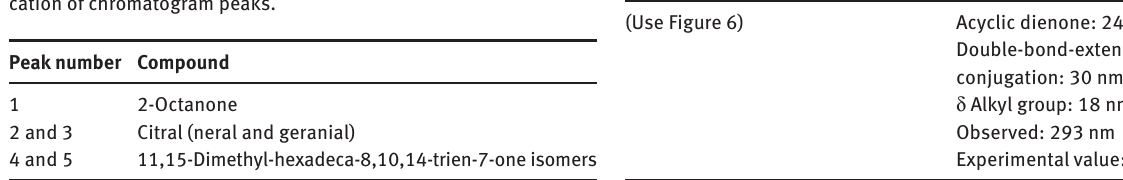
Table 3: Gas chromatography-mass spectrometry (GC-MS) identifi- cation of chromatogram peaks.